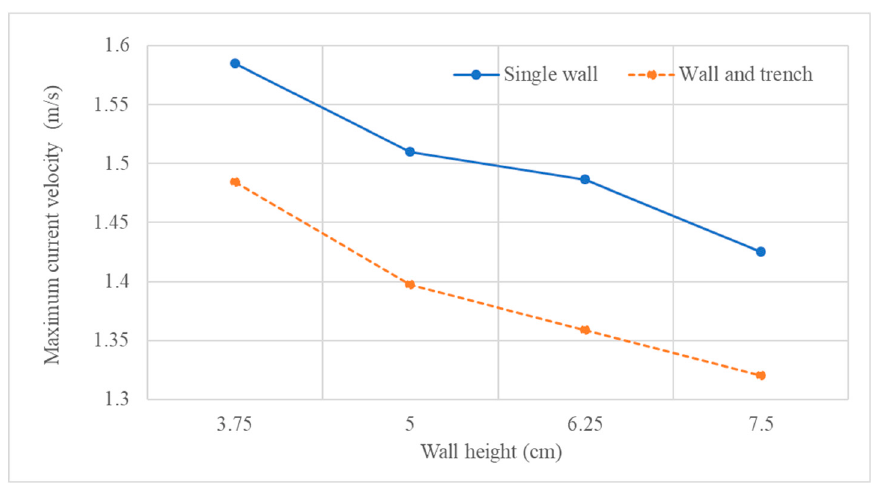
Figure 21. Comparison of maximum water levels observed at location D.